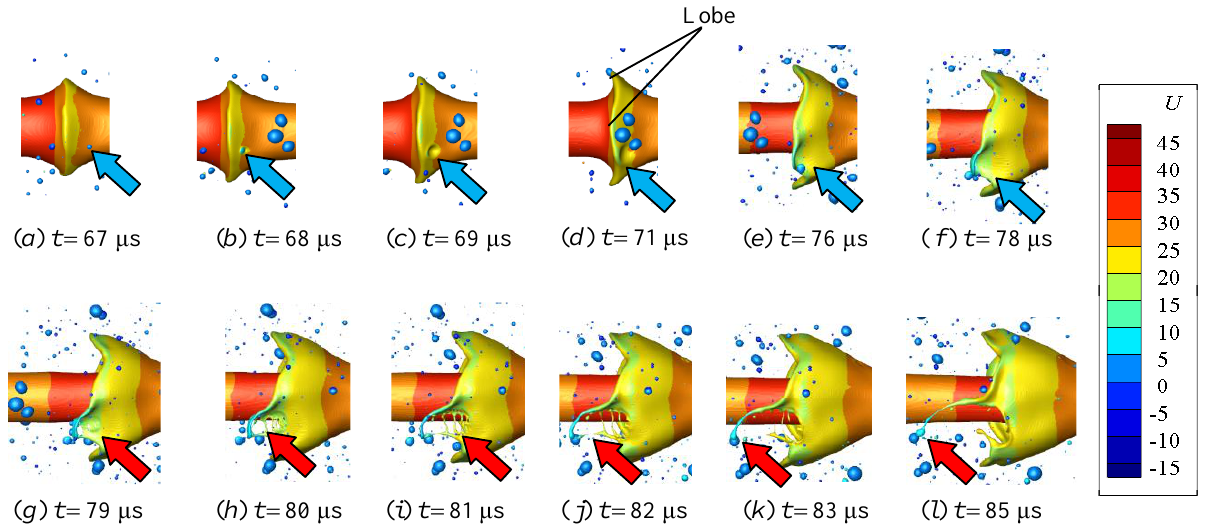
Figure 10. Ligament formation on liquid bridges ( f = 66.6 kHz). The color indicates the axial velocity in m/s.